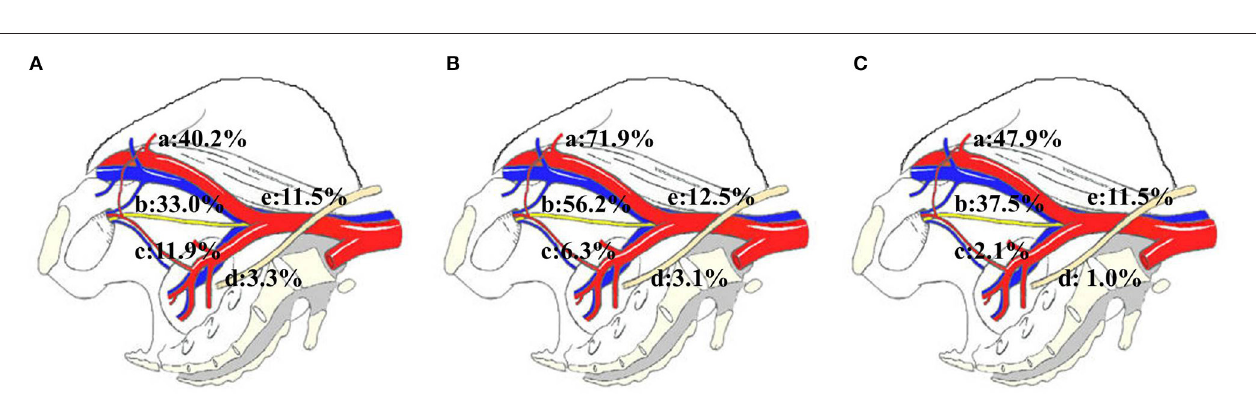
FIGURE 2 | The distribution of pelvic lymph node metastasis in the external iliac zone a, obturator zone b, internal iliac zone c, presacral floor zone d, and common iliac zone e. (A) pelvic lymph node. (B) PLNM according to the case analysis. (C) Pelvic lymph node metastasis according to the distribution analysis.